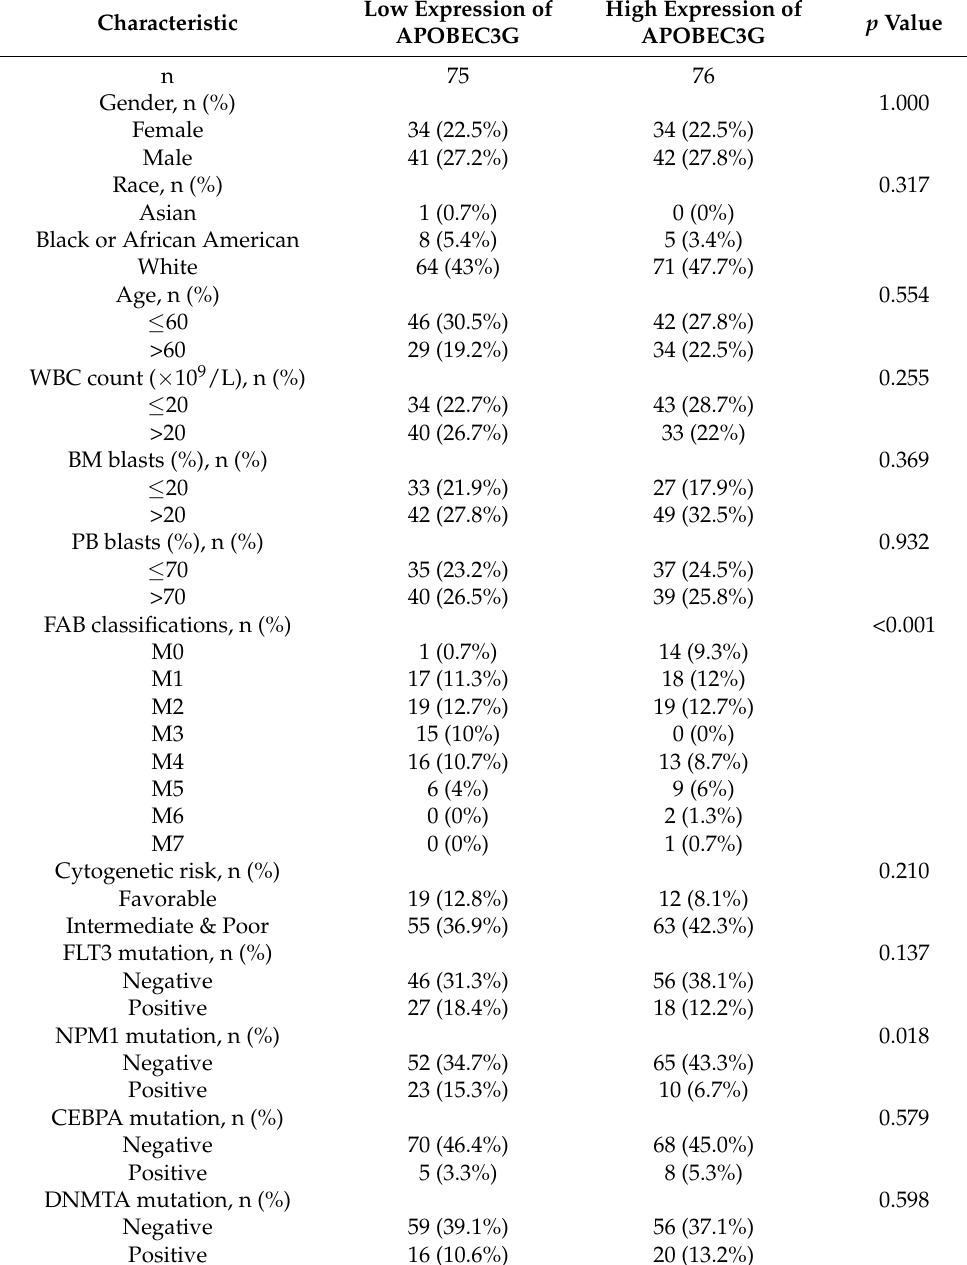
Table 1. Association between APOBEC3G expression and the clinic pathological characteristics in AML